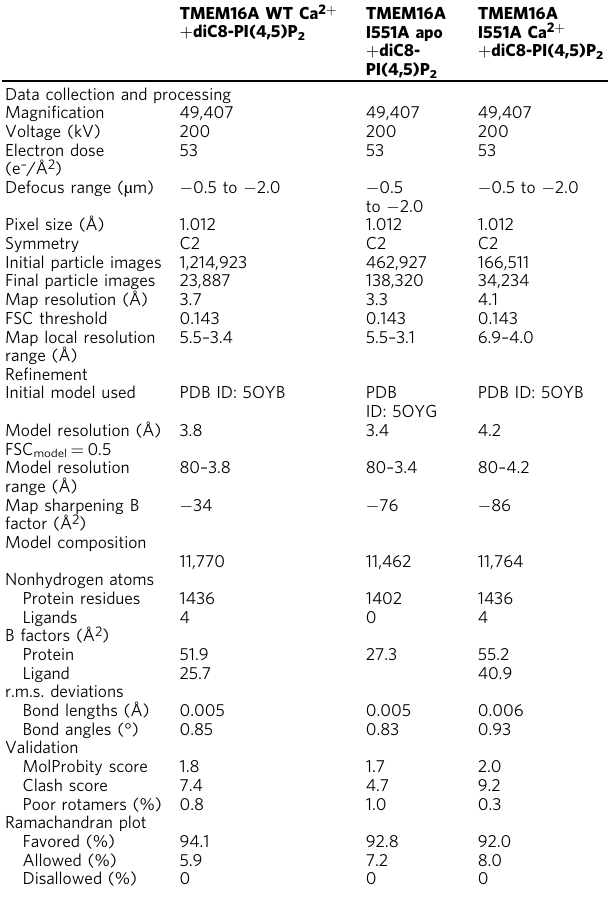
Table 1 Cryo-EM data collection, processing, re fi nement, and validation